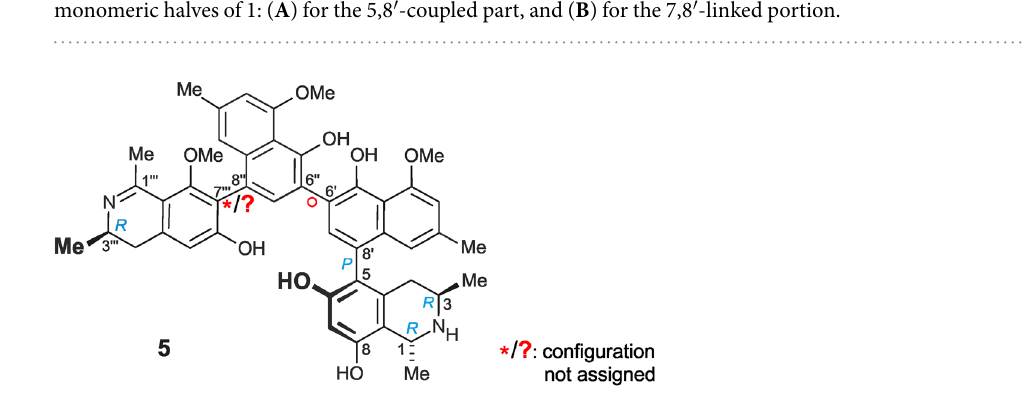
Figure 4. Korundamine A ( 5 ) previously isolated from A. korupensis 15